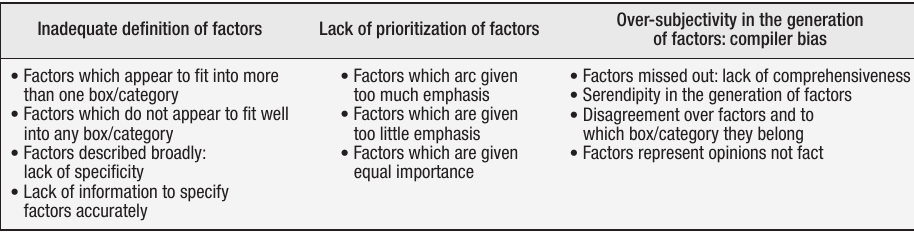
Fig. 6. Limitations of SWOT (Pickton and Wright 1998)